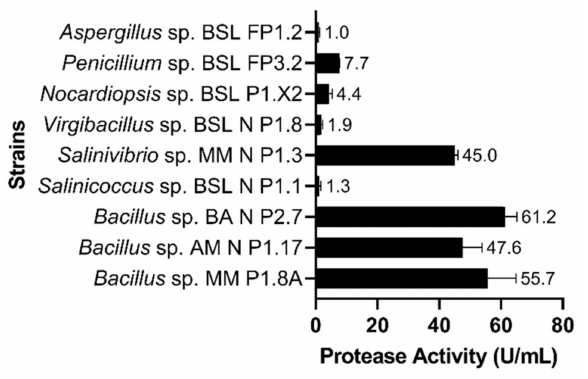
Figure 2. Protease activities, expressed in units per mL, in the culture supernatant. The results are presented as averages of three replicates, and error bars represent the standard deviation of the mean.